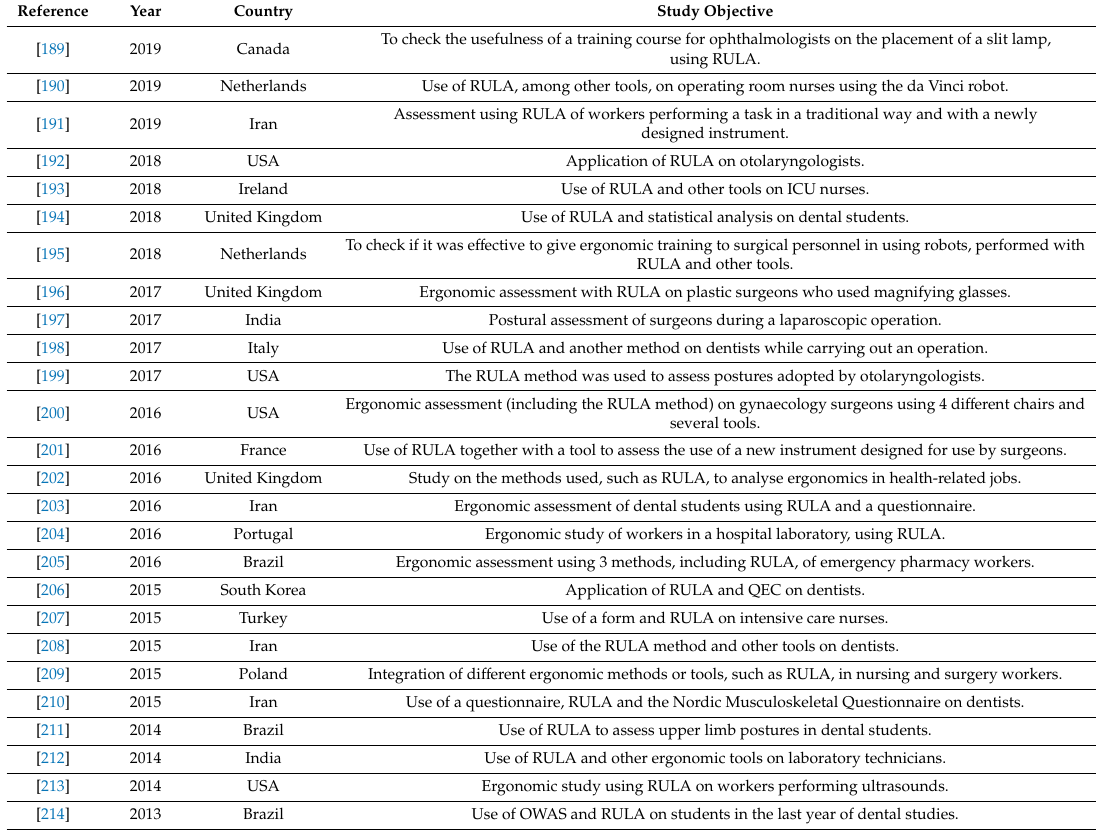
Table 17. Human health and social work